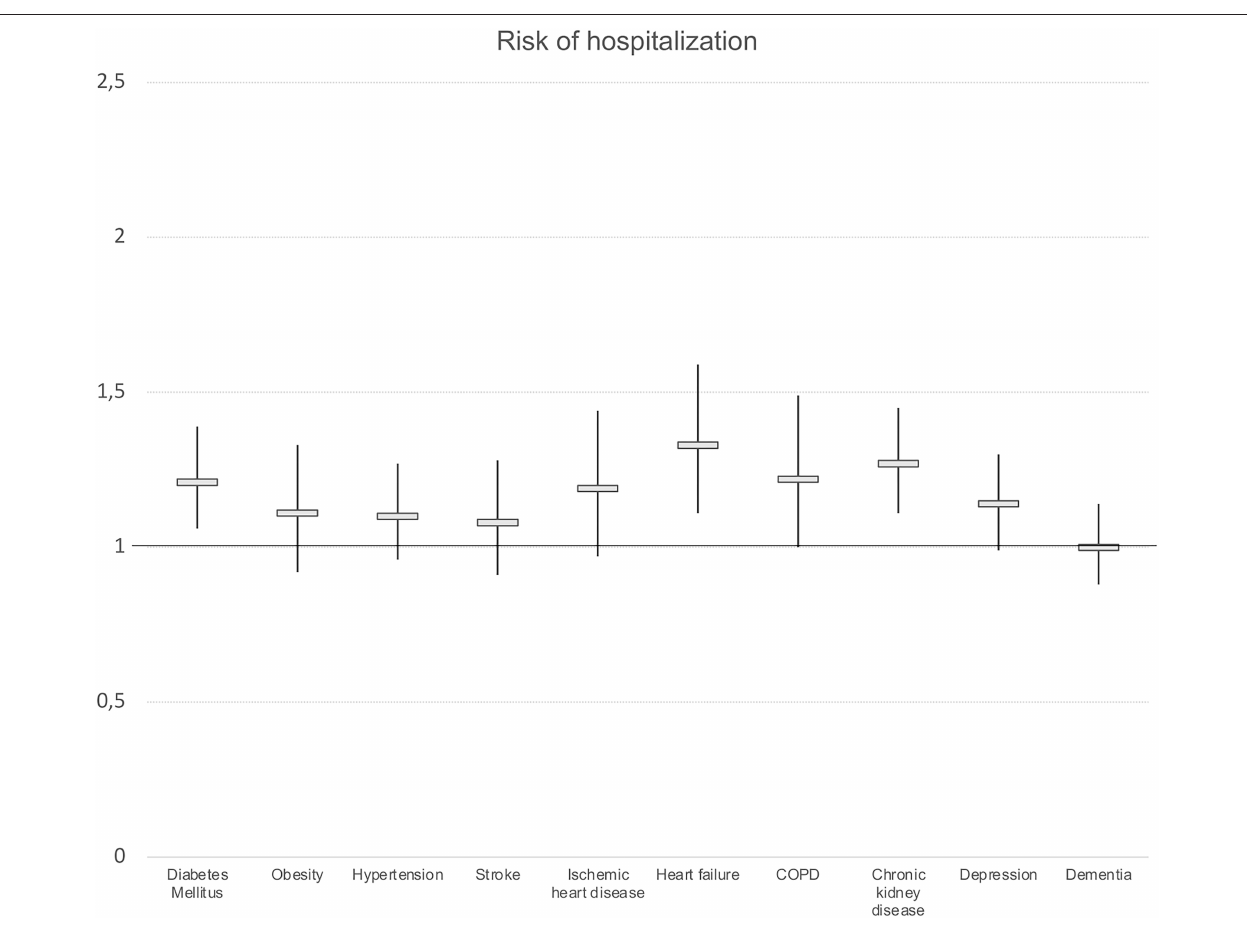
FIGURE 2 | Presence of chronic morbidity and risk of hospitalization. Logistic regression models. Odds ratios and 95%Confidence intervals. Results adjusted by sex, age and socioeconomic level. COPD, chronic obstructive pulmonary disease.